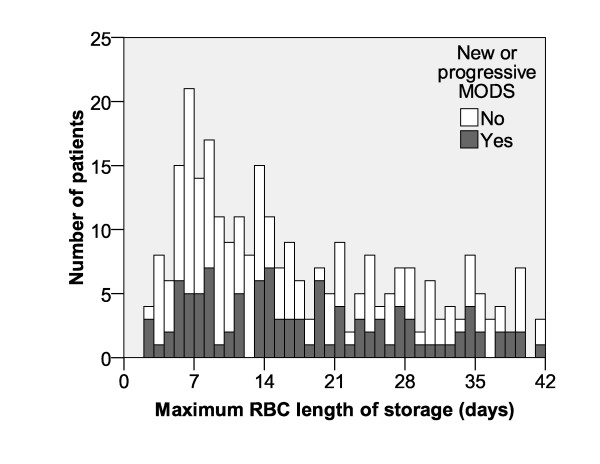
Distribution of RBC length of storage. The horizontal axis represents the red blood cell (RBC) length of storage (in days). The vertical axis represents the number of patients who received transfusions for each known length of storage. The black part of each bar of the histogram represents the number of patients who developed new or progressive multiple organ dysfunction score (MODS). For patients receiving multiple transfusions, the longest length of storage was used. The median length of storage is 14 days, and the mean length of storage is 17.2 days.